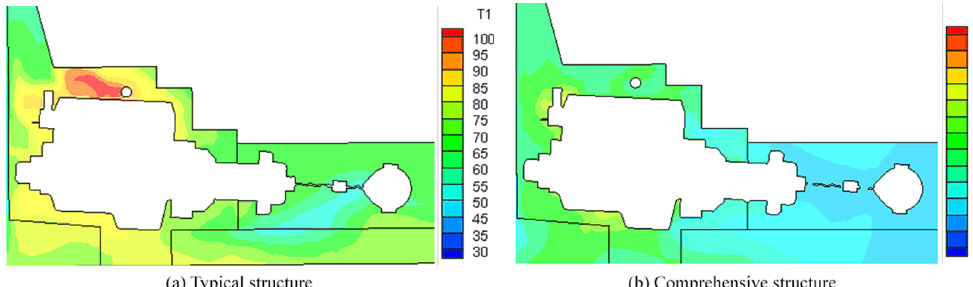
Figure 13. Comparison of temperature fields within the plane X = 38mm (unit: ◦ C).